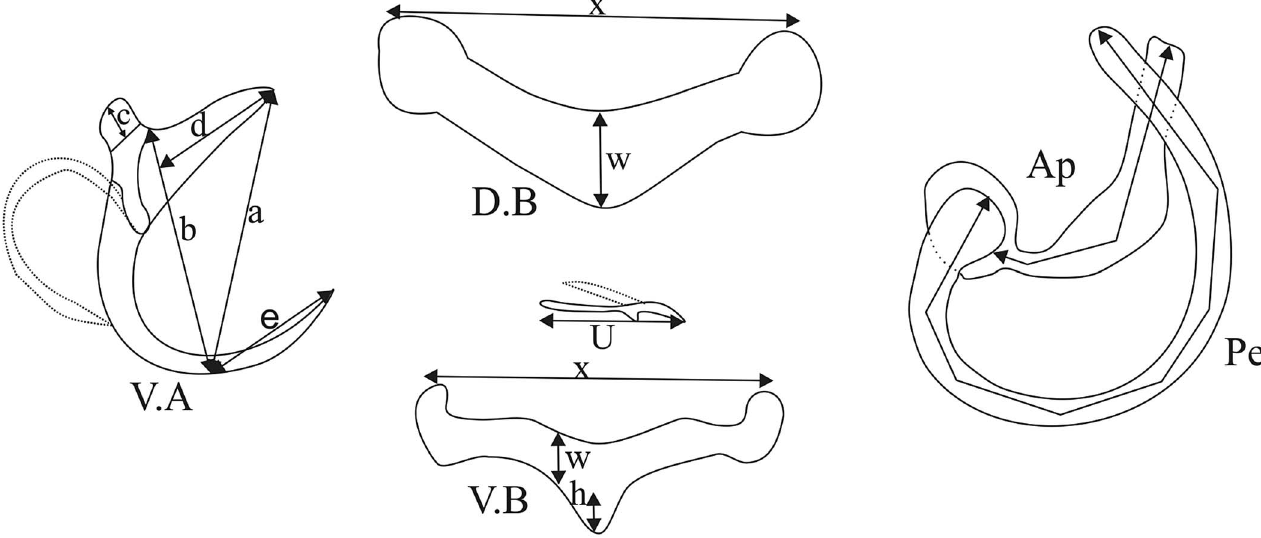
Figure 2. Measures used in this study. V.A: ventral anchor; a : total length; b : blade length; c : shaft length; d : guard length; e : point length. D.B: dorsal bar; w : maximum width; x : length. V.B, ventral transverse bar; h , length of protuberance; w , maximum width; x , length. Ap: accessory piece length. Pe: penis length. u , length of marginal